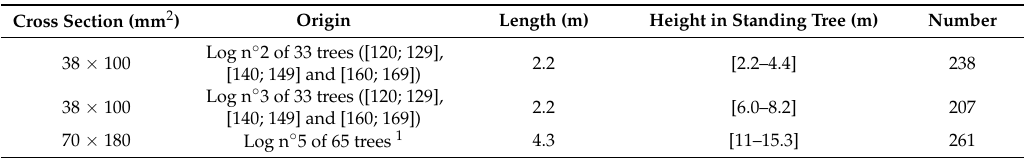
1 The smallest tree of stand PHB broke at 13 m height when it was